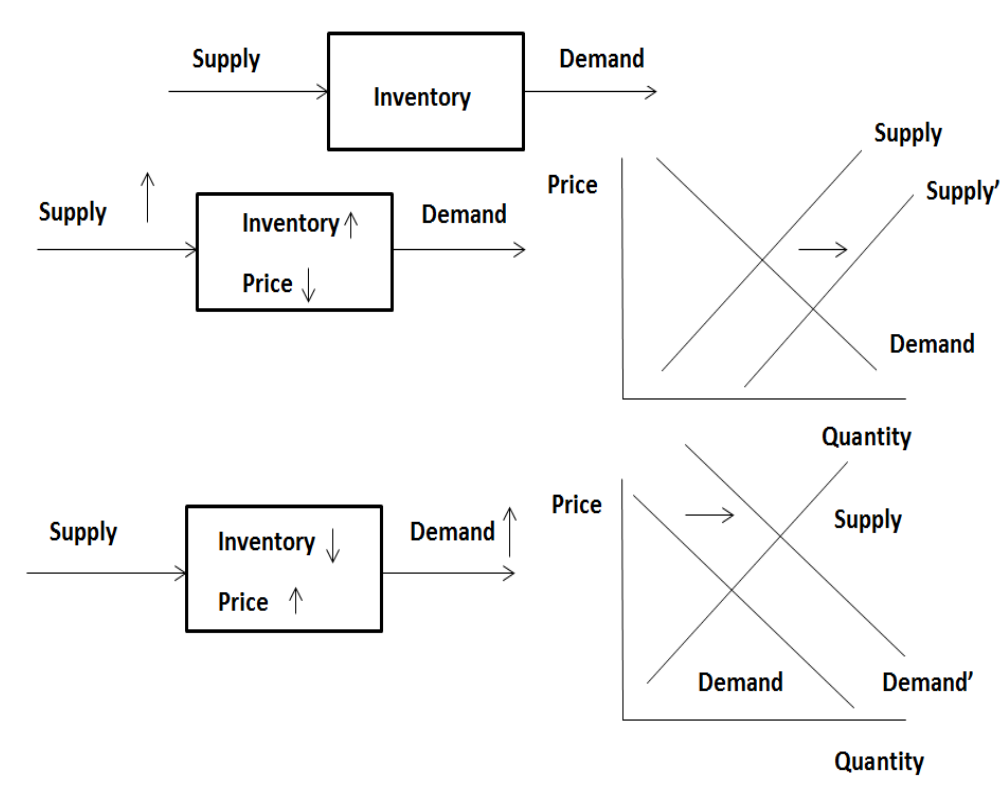
Figure 2 : Movement of Price with